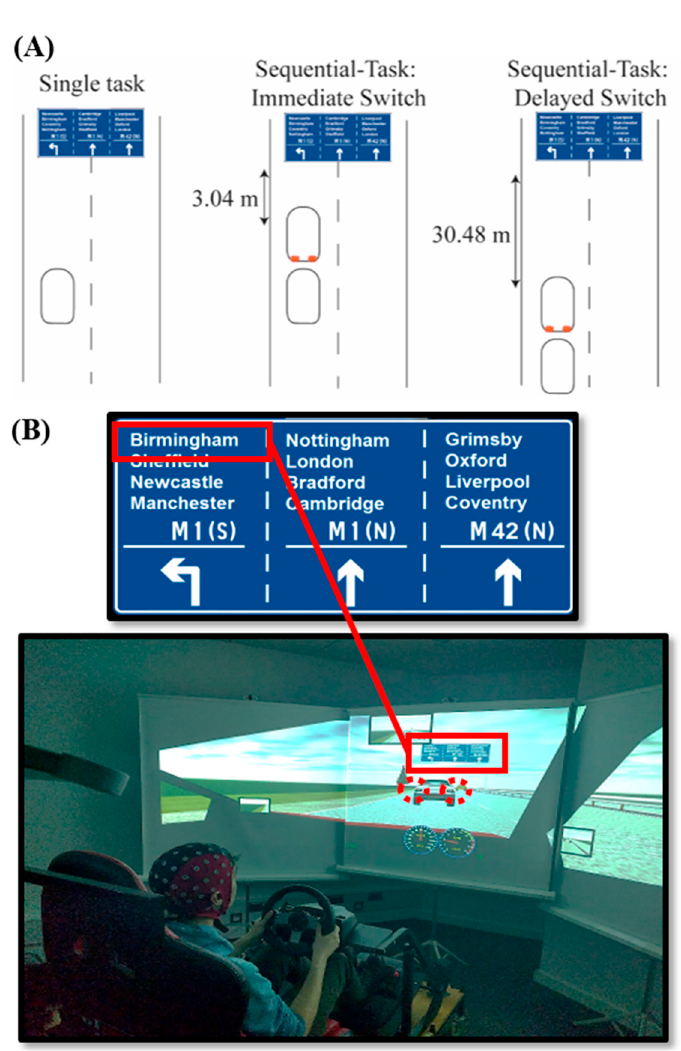
Figure 1. ( A ) Illustration of the three task conditions, including (from left to right) Single-Task, Sequential-Task Immediate Switch and Sequential-Task Delayed Switch. Curved rectangles represent the simulated vehicles of the participant (plain) and in the braking event (with red brake lights illustrated); ( B ) Example of the experimental setup, where the participant is seated in the driving simulator wearing an EEG cap. The projector screen displays the vehicle involved in the “braking event” (1st task; dashed red circles emphasize the brake lights), along with the road sign (2nd task, which always appeared after the braking event) during a Sequential-Task trial. As displayed enlarged at the top, the target word “Birmingham” is listed in the left column of the sign, requiring a speeded left indicator response (the location of the target on the sign varied across trials).